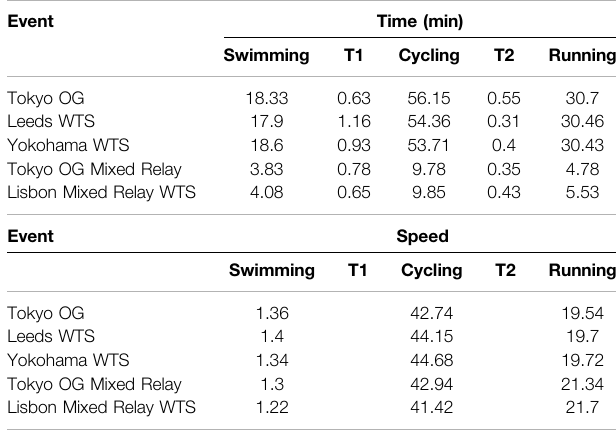
TABLE 4 | The performance in the races during the season